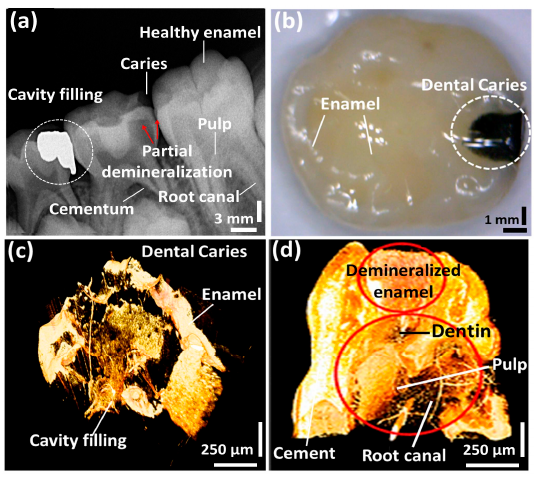
Figure 7. Structural analysis of the carious tooth sample using various inspection